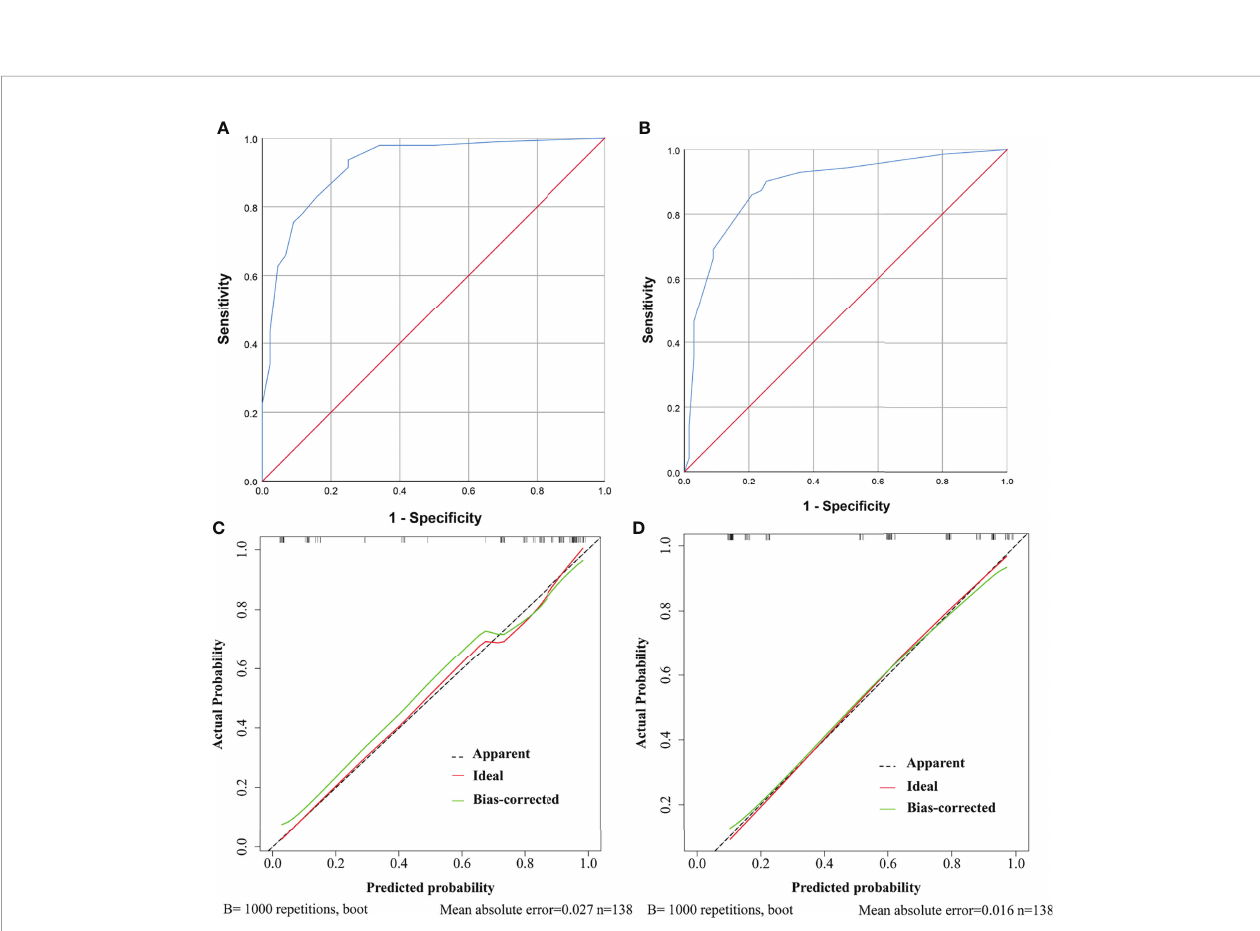
FIGURE 4 | ROC curves and calibration curves of the models showing predictive performance for need for anterior pituitary hormone replacement 1 year after surgery and permanent diabetes insipidus (DI) in the training cohort. (A) The AUC of the model for need for anterior pituitary hormone replacement is 0.921, with 95% CI ranging from 0.871 to 0.970. (B) The AUC of the model for permanent DI is 0.885, with 95% CI ranging from 0.827 to 0.943. (C) Calibration curve of the prediction model for need for anterior pituitary hormone replacement. The grey dashed line represents the apparent curve (non-correction), the green line represents the bias-correction curve, and the red line represents the ideal curve. B = 1,000 repetitions; n = 138, mean absolute error = 0.027. (D) As in (C) but for permanent